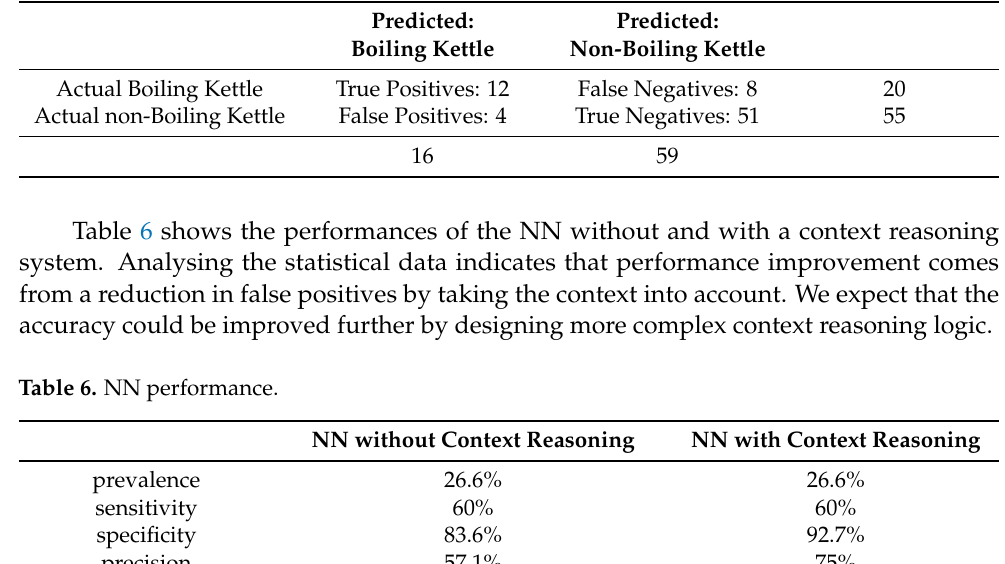
Table 5. Neural network confusion matrix with context reasoning.